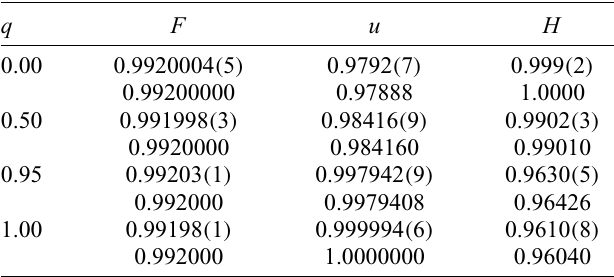
TABLE VI. Processed data for p = 0.01 in the two-qubit 2- RB. In each cell, fitting results are written in the first line and theoretical values are written in the second line.